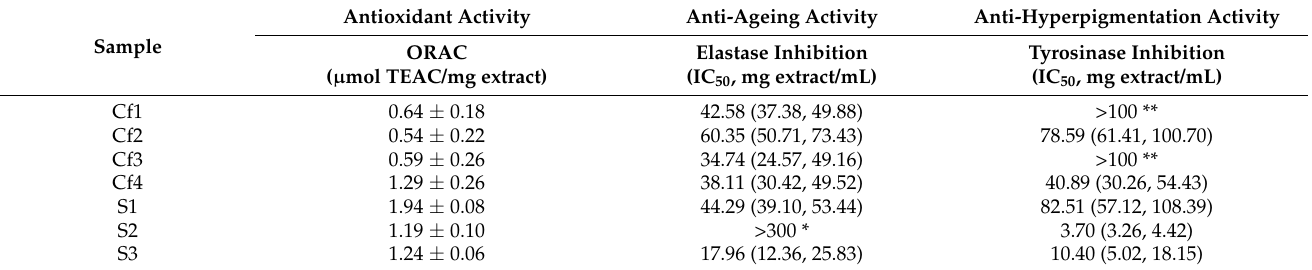
Table 2. Antioxidant, anti-ageing, and anti-hyperpigmentation activities of codfish and sardine residues extracts. ORAC values are expressed as the mean value ± SD. Enzymatic assays IC 50 values are expressed as mean with a 95% confidence